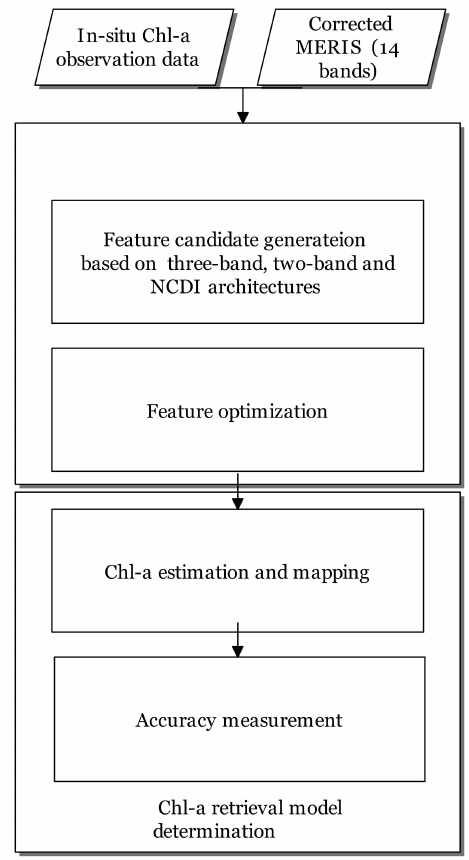
Figure 3. Procedures of the study, including feature candidate generation from three-band, two band, and the normalized di ff erence chlorophyll index (NDCI), as well as feature optimization and Chl-a retrieval model